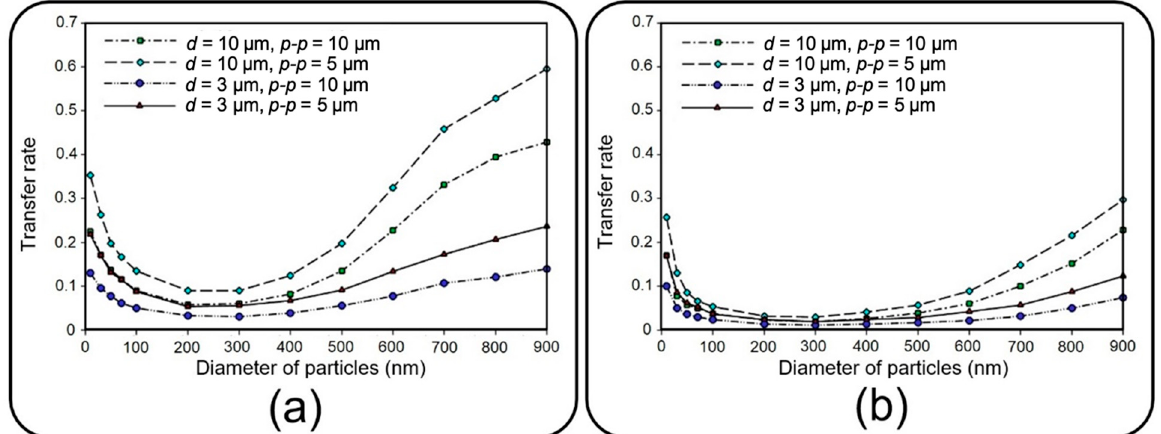
Figure 12. Transfer rate of NPs of diameter ranging from 10 nm to 900 to the media channel of the lung-on-a-chip device with different membrane porosities considering equal inflow velocities of ( a ) 0.3 mm/s and ( b ) 1 mm/s for air and media channels.